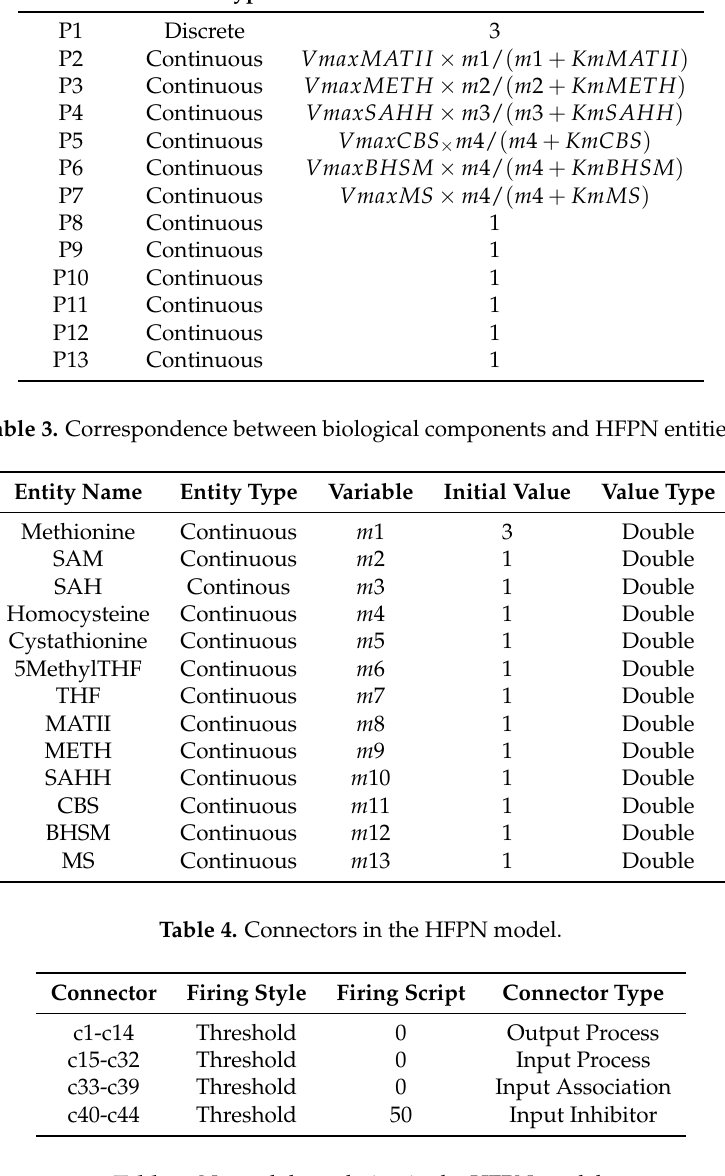
Table 5. Natural degradation in the HFPN